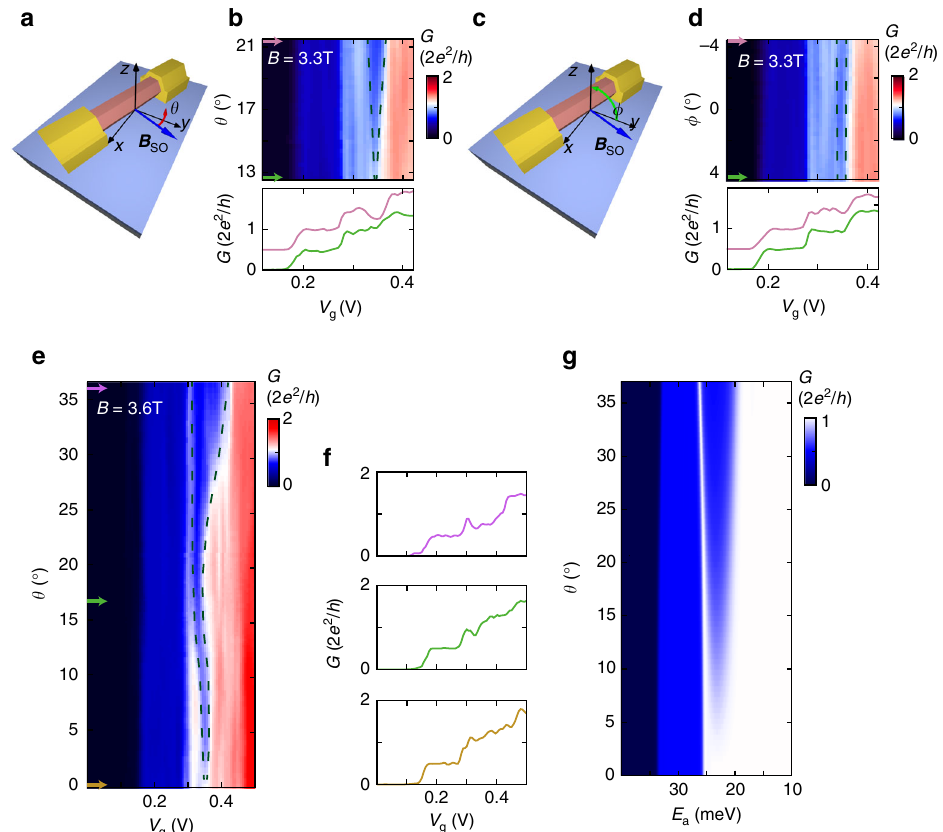
Fig. 4 Angle dependence of the helical gap. a Illustration of the magnetic fi eld orientation in b . When rotating along θ the magnetic fi eld lies in the x – y plane and is aligned with B SO at θ = 0° b , Rotation of the magnetic along θ at B = 3.3 T, shows a strong angle dependence of the helical gap. The conductance dip closes when B is rotated toward B SO and opens when B is rotated away from B SO . Linecuts taken at θ = 12.9° ( green arrow ) and θ = 21.1° ( pink arrow ) are shown in the bottom panel . c Illustration of the magnetic fi eld orientation in d . When rotating along Φ the magnetic fi eld lies in the x – z plane. At Φ = 0° B is aligned with the y -axis at at a small offset angle relative to B SO . d Rotation of the magnetic fi eld along Φ at B = 3.3 T, mostly perpendicular to B SO, with linecuts at Φ = − 4.1° ( pink arrow ), and Φ = 4.1° ( green arrow ), added in the bottom panel . While the angle range is identical to b , there is little change in the conductance dip. e Rotation of the magnetic fi eld along θ at B = 3.6 T over a large angle range. The conductance dip disappears when B is parallel to B SO which gives the exact offset angle between B SO and B Z , θ = 17°. f Linecuts of e taken at θ = 0° ( brown arrow ), θ = 17° ( green arrow ), and θ = 37° ( pink arrow ), additional linecuts are shown in Supplementary Fig. 4. g Numerical simulations of the differential conductance in a magnetic fi eld rotated along θ with L = 325 nm and l SO = 20 nm. Black dashed lines indicating the width of the helical gap are added as guide to the eye in b , d ,